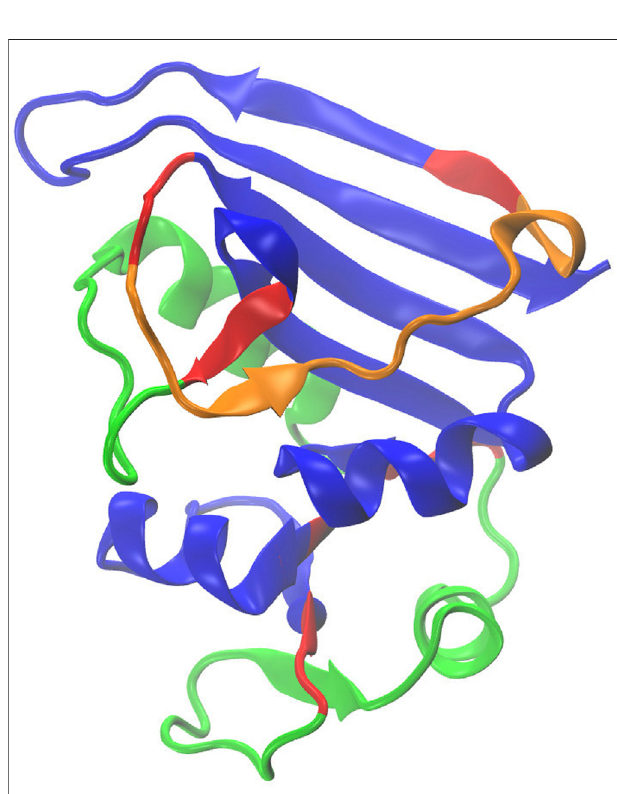
FIGURE 2 | Structure of DHFR (PDB-ID 1RX2) that was used in this study with color annotation based on the simulated dynamics. The blue sections correspond to the fi xed region while the green sections correspond to the rigid-body dynamics. The section illustrated in red section was subjected to no constraints and was subject to free motion (uncorrelated